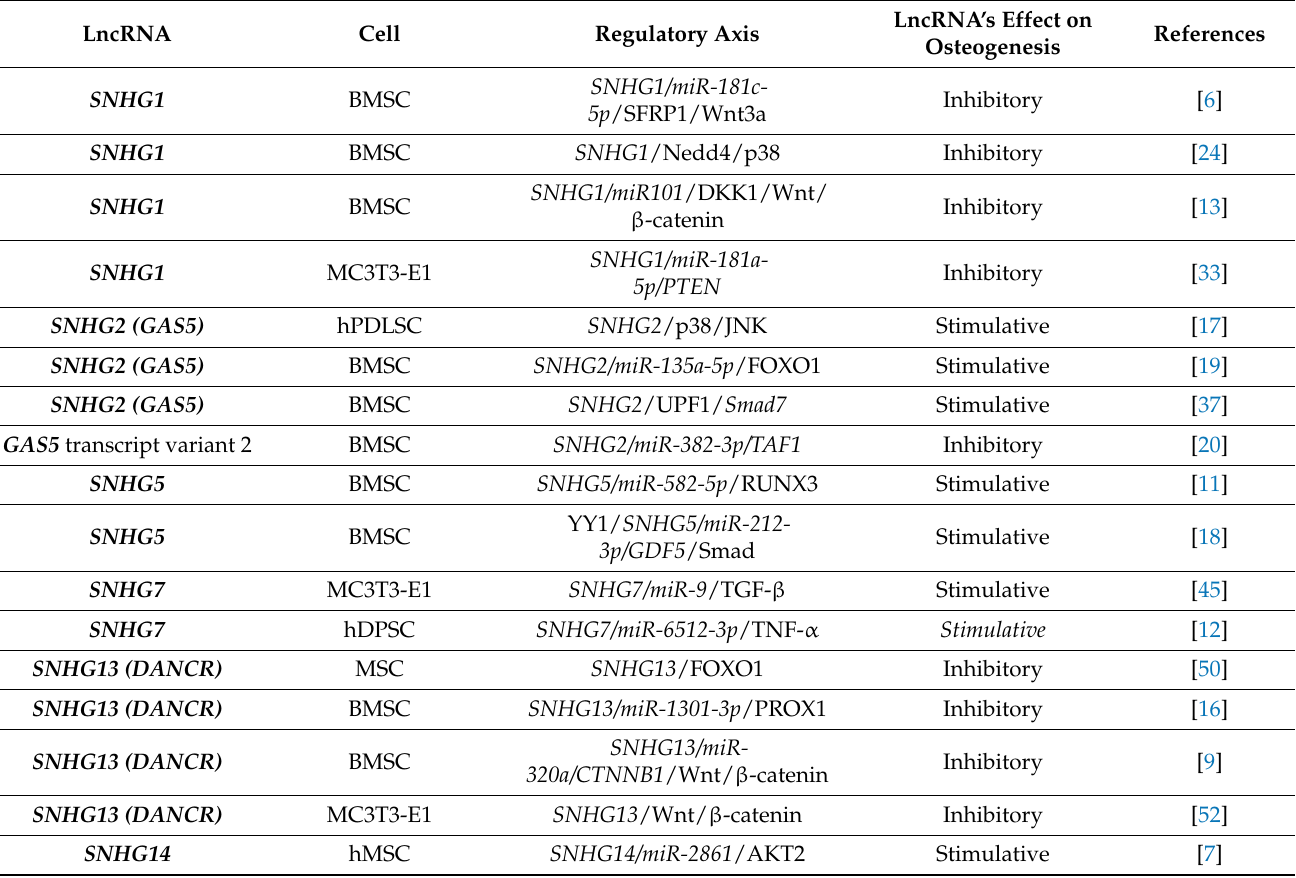
Table 2. Key SNHGs regulate osteoblast